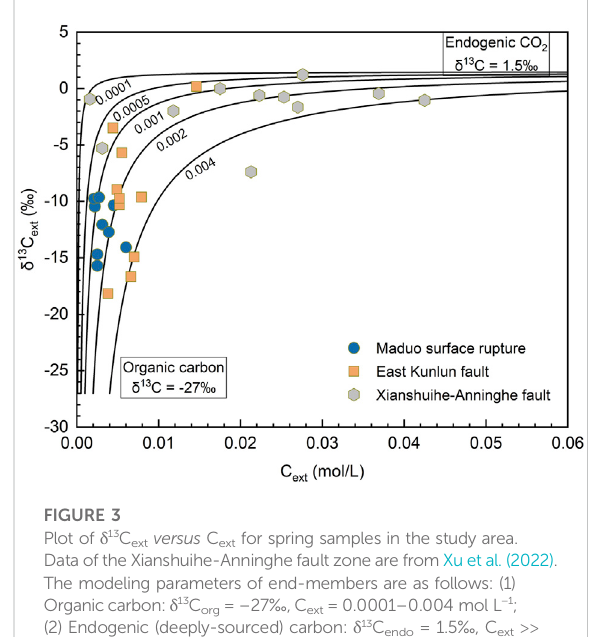
FIGURE 3 Plot of δ 13 C ext versus C ext for spring samples in the study area. DataoftheXianshuihe-AnninghefaultzonearefromXuetal.(2022). The modeling parameters of end-members are as follows: (1) Organiccarbon: δ 13 C org = – 27 ‰ ,C ext =0.0001 – 0.004 mol L − 1 ; (2) Endogenic (deeply-sourced) carbon: δ 13 C endo = 1.5 ‰ , C ext >> 0.06 mol L − 1 .The δ 13 Cvalueofdeeply-sourcedcarbonend-member represents a mixture of carbon from mantle degassing and decompositionofmarinelimestones.The δ 13 Cvalueofmetamorphic CO 2 depends on that of source rocks, and we cannot discriminate carbonfrommantledegassingandmetamorphicdecarbonationdue to the lack of further geochemical data (e.g., 3 He/ 4 He) in this study. The numbers (i.e., 0.0001, 0.0005, 0.001, 0.002, and 0.004) near corresponding mixing curves represent carbon contents (shown in C ext ) of organic carbon end-member.